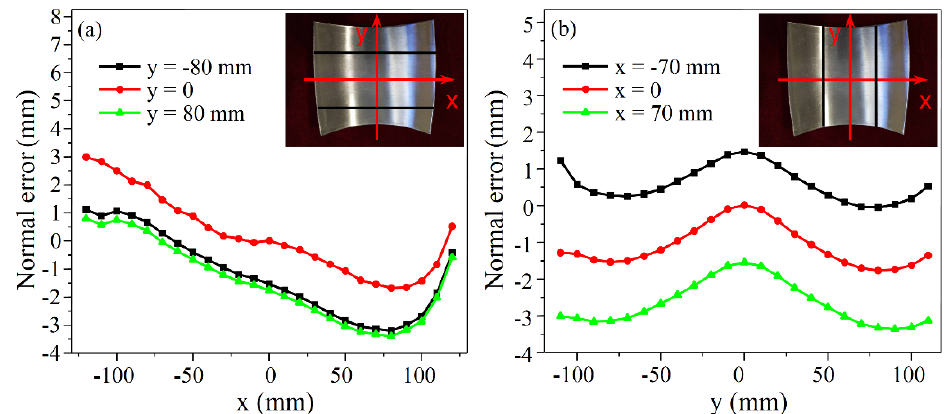
Figure 15. Normal error of the profile curves for positive Gaussian curvature surface: ( a ) Longitudinal; ( b ) Transverse.